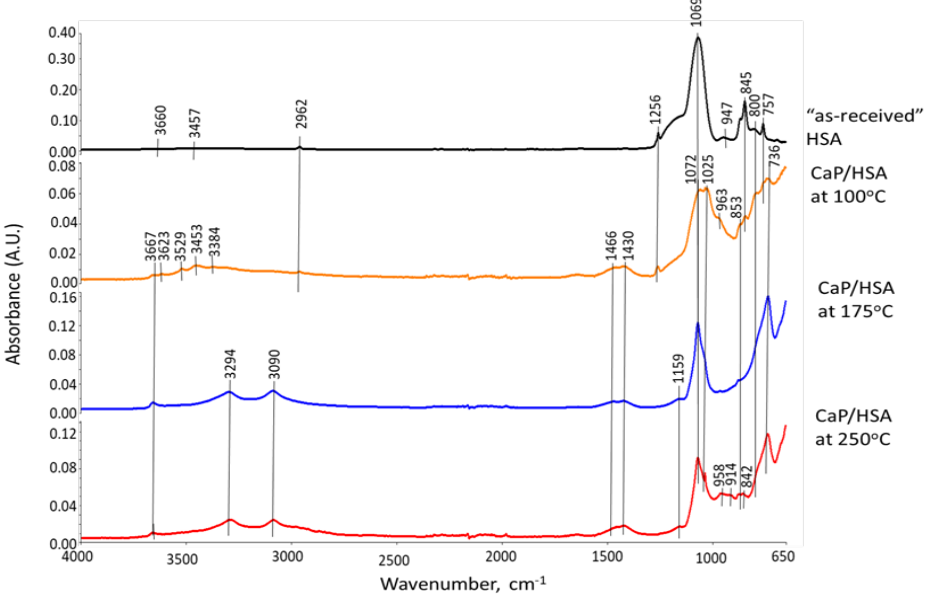
Figure 15. ATR-FTIR spectrum analysis of 100-, 175-, and 250 °C-autoclaved CaP/HSA system.